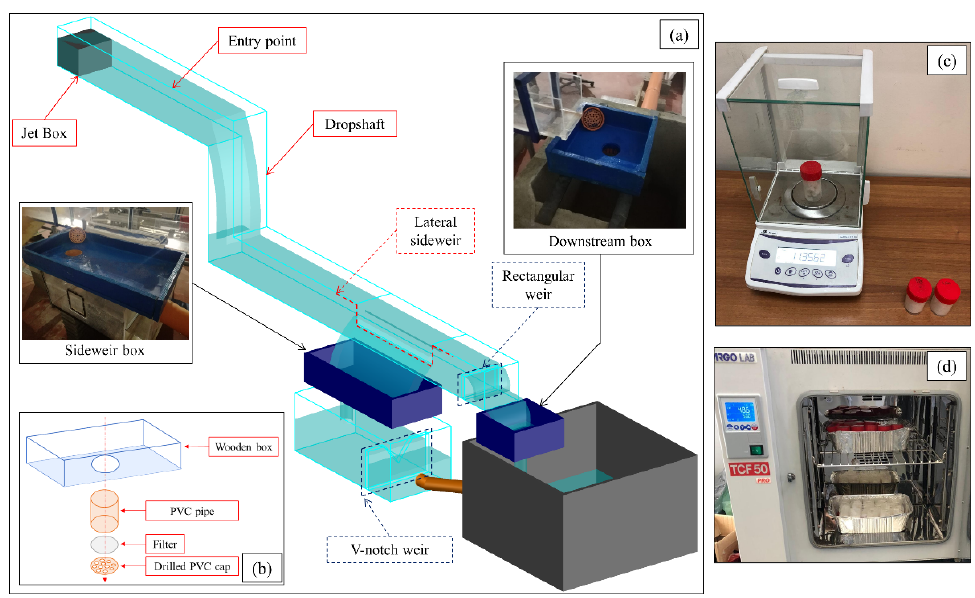
Figure 1. Laboratory model ( a ); sketch of the fiber collecting system ( b ); sampling and weighing of the nylon fibers ( c ); oven-drying process ( d ).